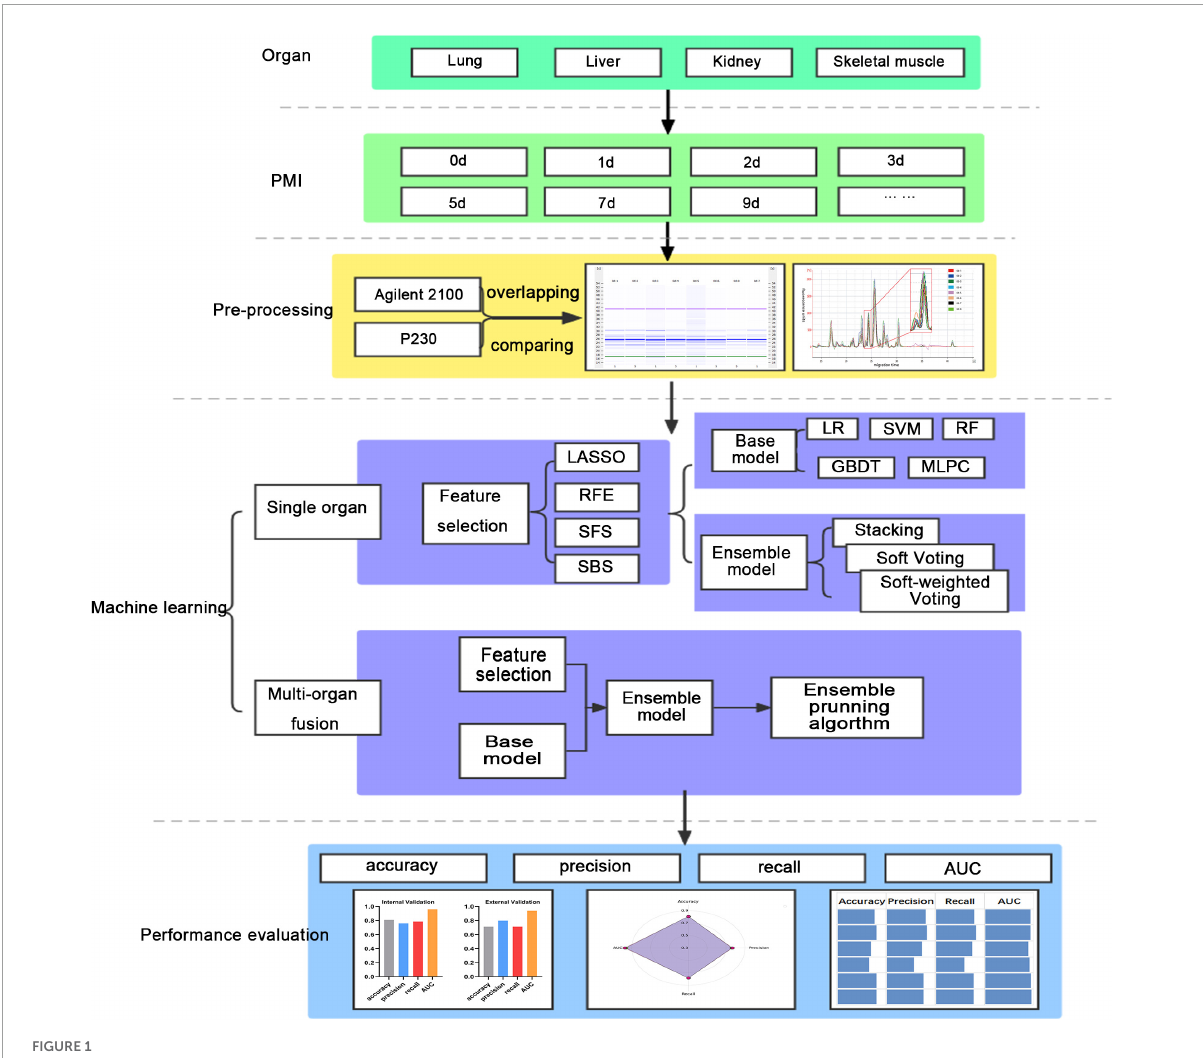
FIGURE1 The workflow of this